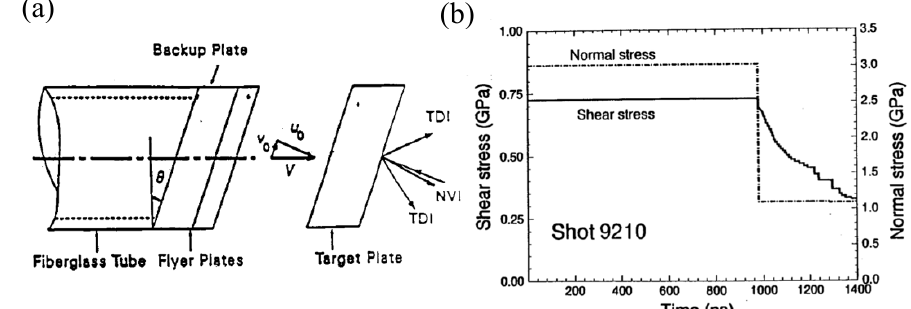
Fig. 1. (a) Experimental setup employed by Prakash and Clifton (1993) [1] to produce sudden normal stress variations. (b) Effect of sudden normal stress change on shear stress which is equal to shear resistance during slip: instead of changing immediately and proportionally, the shear stress experiences gradual evolution. Modified from Prakash and Clifton